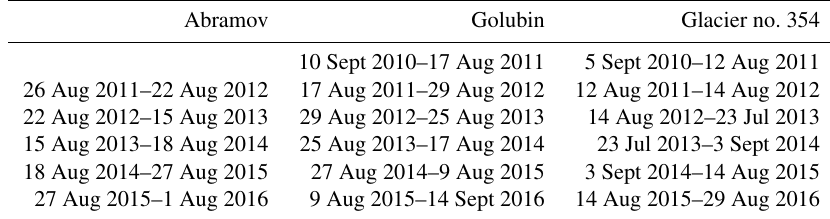
Table 2. Survey period of glaciological measurement for each glacier and each year. Abramov Golubin Glacier no.